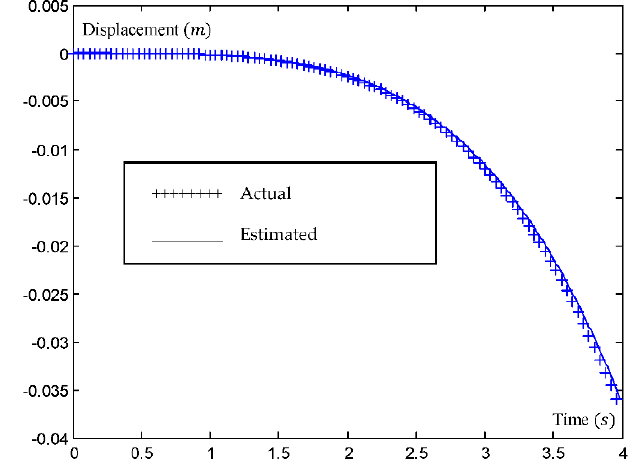
Figure 6. Translation according to xR.